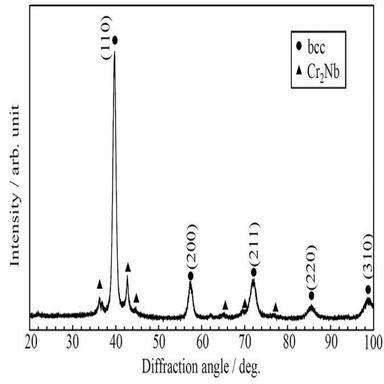
XRD pattern of a sintered TiCrNbMoTa specimen.